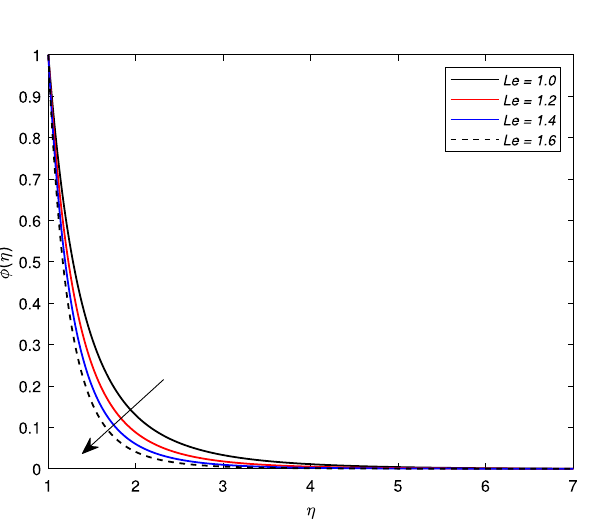
Figure 12. Impact of thermophoresis parameter Nt on concentration profile φ(η) .